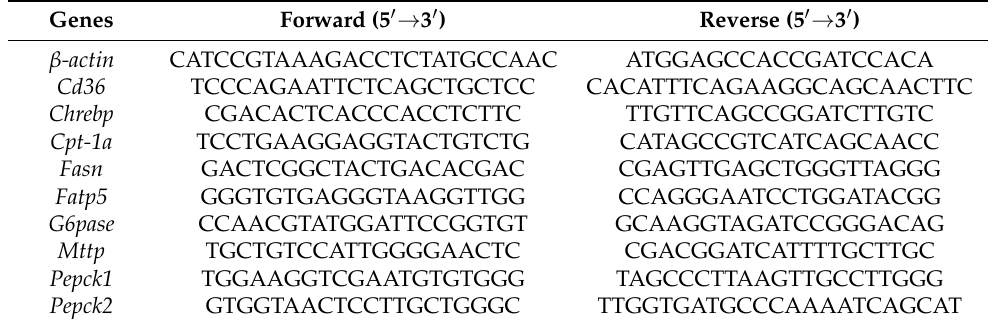
Table 1. Sequences of the primers synthesized for this study.